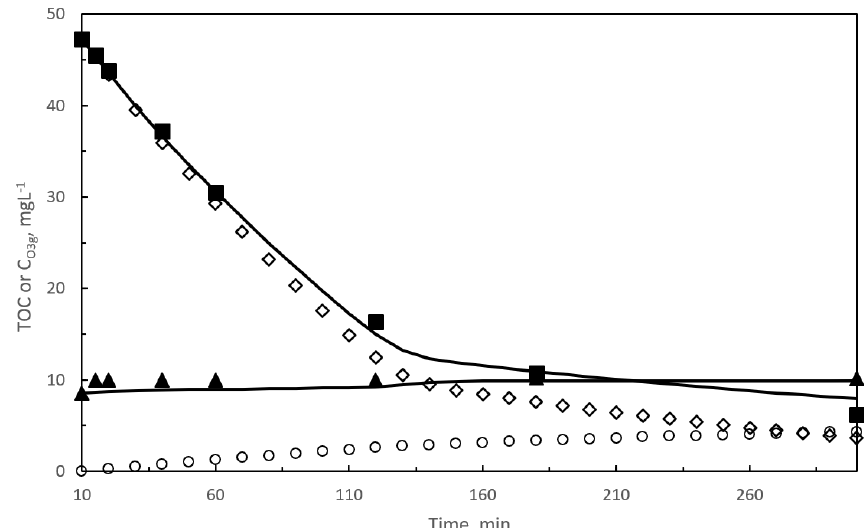
Figure 7. Kinetic model results in photocatalytic ozonation. Second reaction period. Changes with time of calculated and experimental concentrations of TOC (TOC 1 and TOC 2 ) and ozone in the gas leaving the reactor. Black symbols: experimental results: (cid:4) TOC, (cid:78) C O3g . Empty symbols: calculated TOC 1 , TOC 2 . Curves: TOC and C O3g calculated results. Experimental conditions as in Figure 2. Experimental TOC values taken from [30].